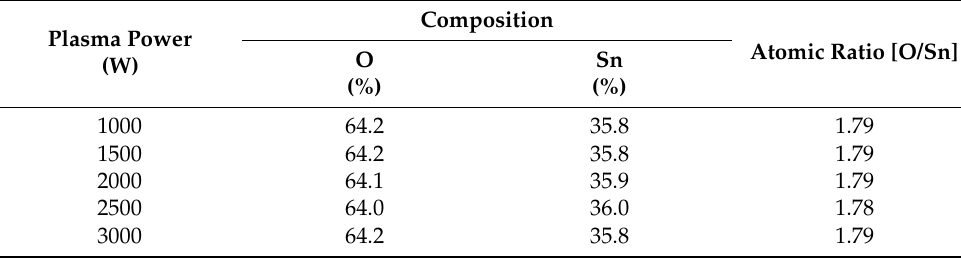
Figure 5. ( a ) The O 1s core level spectra via X-ray photoelectron spectroscopy (XPS) for SnO 2 thin films deposited at different plasma power from 1000 to 3000 W with the deconvolution of sample at 1000 W and the ( b ) ratio of oxygen vacancies (O V ) to lattice oxygen (O L ) and the Sn 4+ /(Sn 2+ + Sn 4+ ). Table 1. Elemental composition of SnO 2 thin films prepared at different plasma